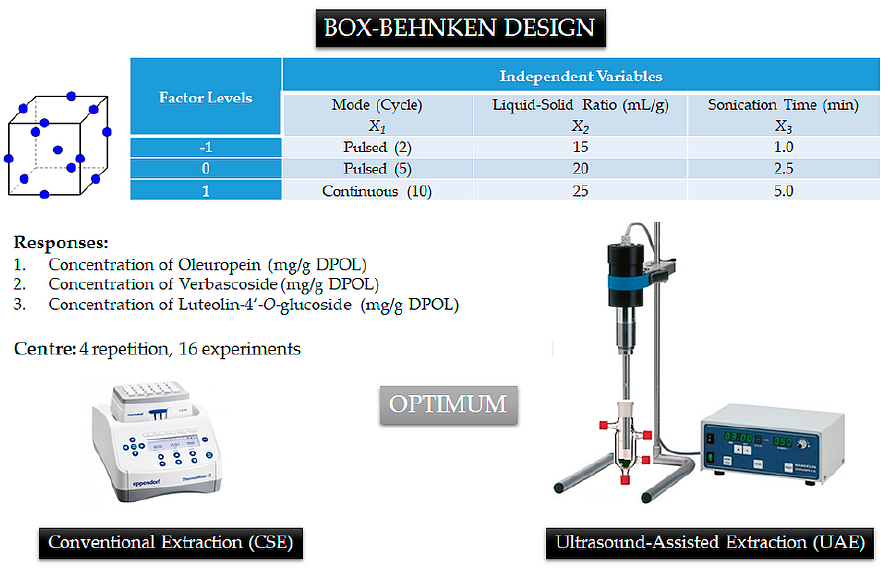
Figure 3. Experimental design with experimental values and coded levels of independent variables used for the Box–Behnken design for ultrasound-assisted extraction (UAE).